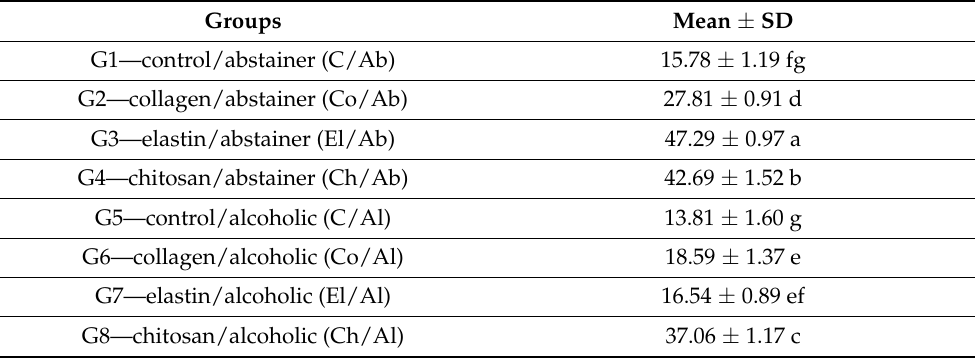
Table 1. Percent volume of newly formed bone.